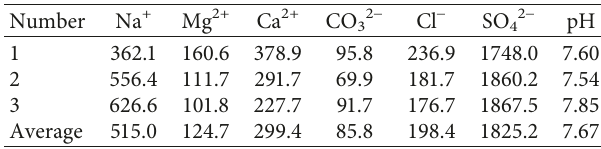
Figure 1: A schematic sketch of the field investigation. Table 1: Chemical composition of seepage water